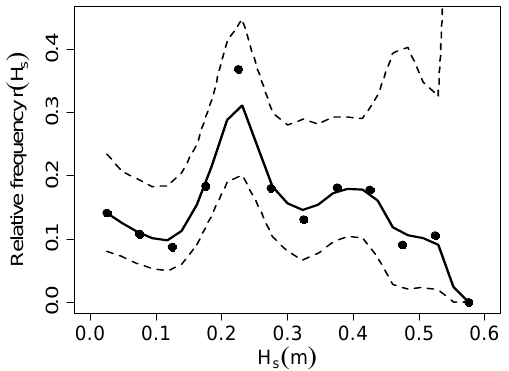
Figure 13. The relative frequency and estimated probability of freak wave occurrence within a 20-minute interval as a function of significant wave height. Dots are observed relative frequencies at 5 cm intervals of H s . The solid line corresponds to a smoothed logistic regression estimate of the corresponding probabilities, and the dotted lines are approximate 95% confidence intervals.